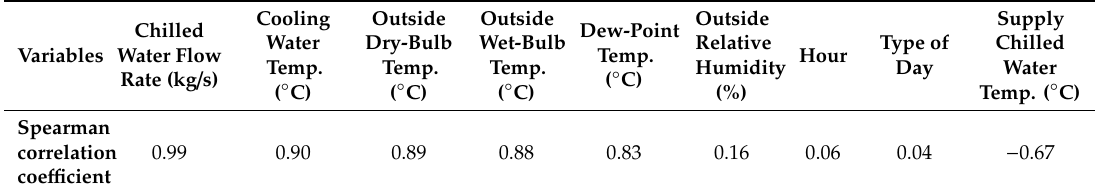
Table 3. Correlation between variables and chiller energy